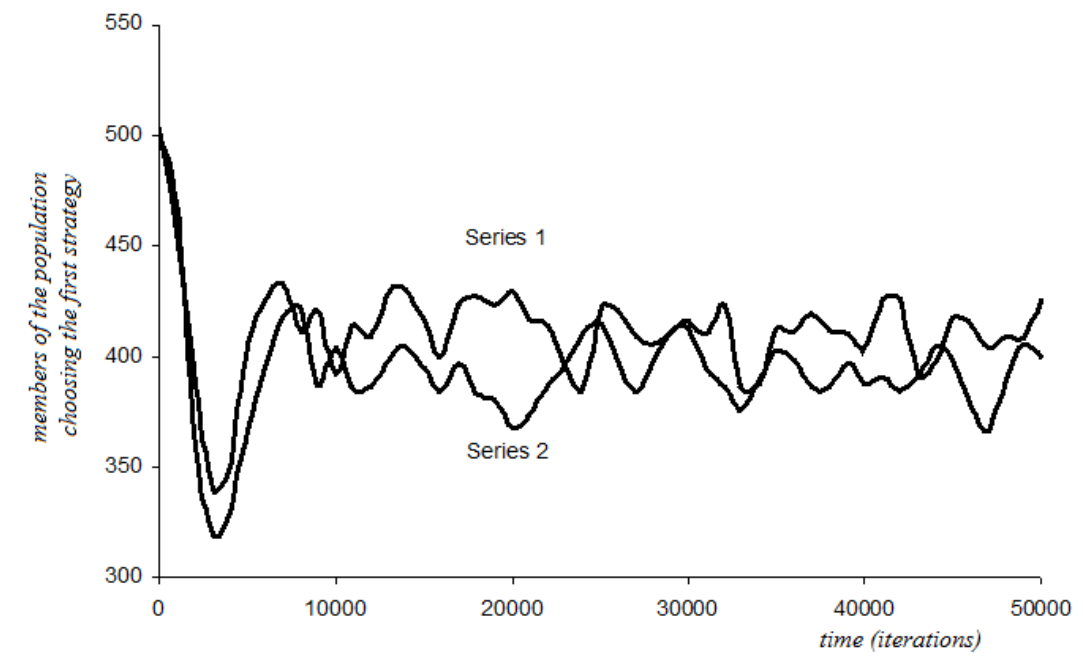
= 0.5. Series 1: a = 0, Series 2: a = 0.1, b = 0